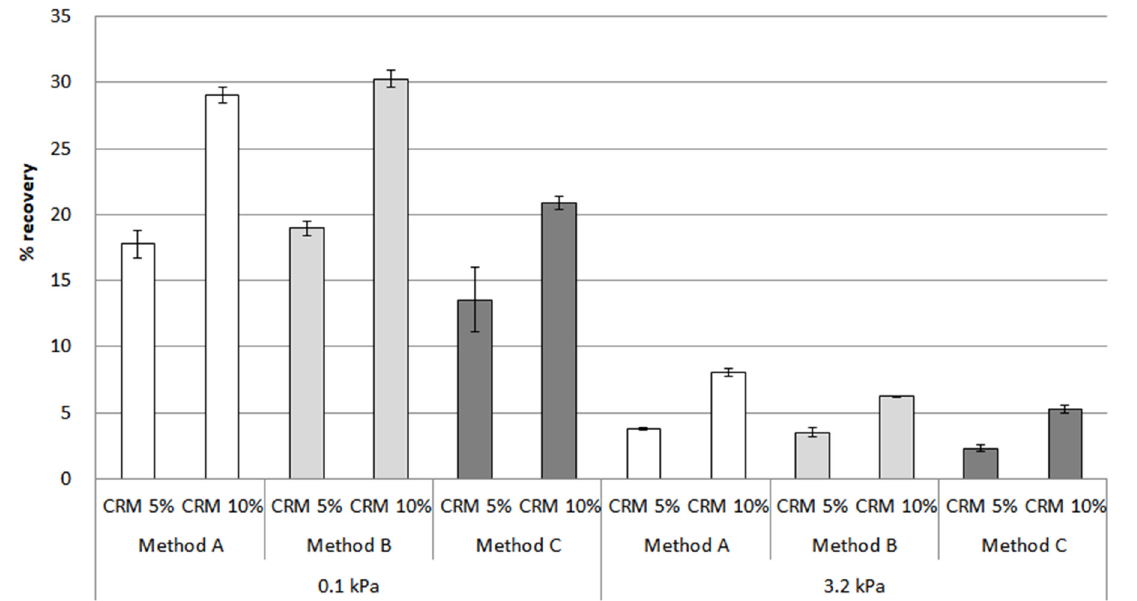
Figure 12. The percentage recovery of the CRM asphalt binders for each mixing method under the original condition.